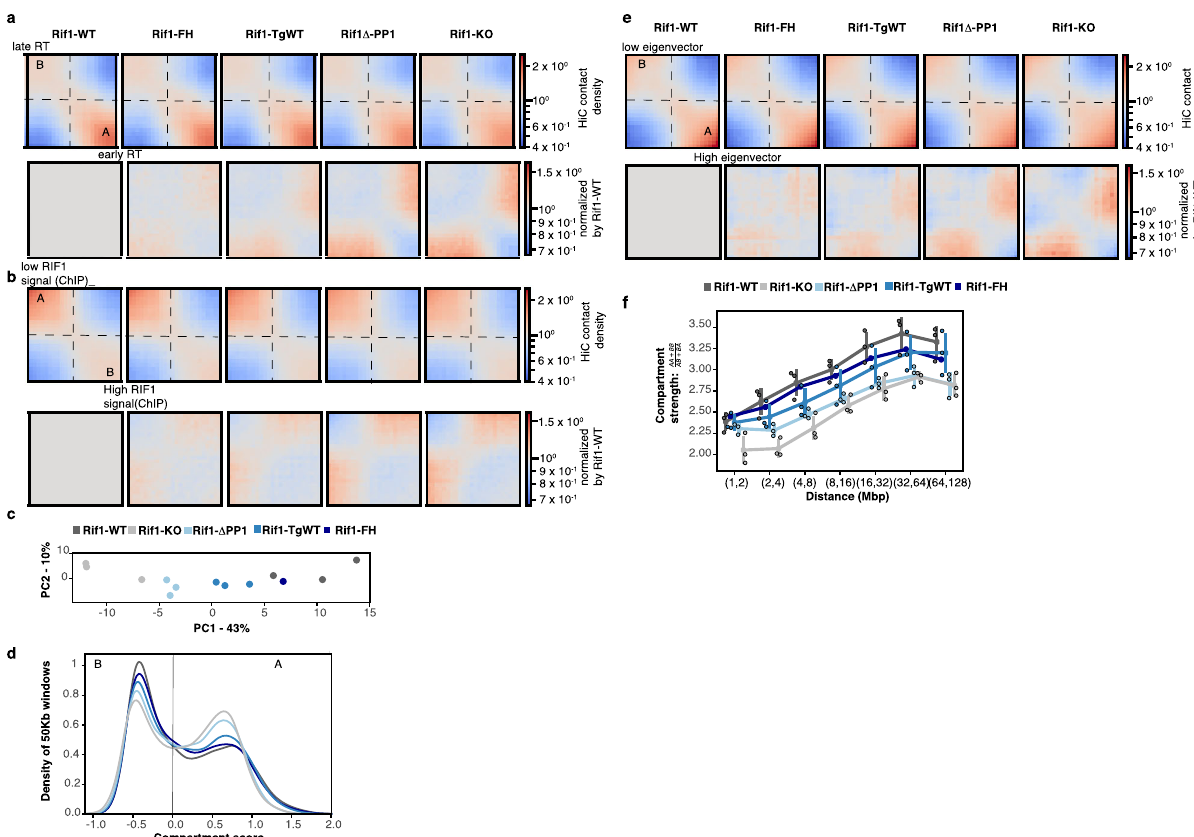
Fig. 4 Segregation of A and B nuclear compartments is sensitive to RIF1 dosage. a Top row: Saddle plot of Hi-C data, binned at 250 kb resolution for loci ranked by their replication timing. An increase in contacts of genomic positions of opposite replication timings is progressively more evident from Rif1-WT to Rif1-KO . The triplicates for each genotype (except for Rif1-FH ) were combined. Lower row: Hi-C for each genotype, data normalised to Rif1-WT . Red indicates a gain in contacts. A and B indicates the compartments. b Top row: Saddle plot of Hi-C data, binned at 250kb resolution for loci ranked by their association with RIF1 13 . An increase in contacts between RIF1-associated and RIF1-devoided genomic positions is progressively more evident from Rif1-WT to Rif1-KO . The triplicates for each genotype (except for Rif1-FH ) were combined. Lower row: Hi-C for each genotype, data normalised to Rif1-WT . Red indicates a gain in contacts. A and B indicate the compartments. c Principle component analysis of A/B compartmentalisation for the indicated genotypes in triplicate, except for Rif1-FH . d Distribution of genomic regions of 250 kb windows between the A and B compartment. Mean of three biological replicates is shown, except for the parental line Rif1-FH . e Top row: Saddle plot of Hi-C data, binned at 250 kb resolution for loci ranked by their eigenvector values. An increase in contacts between genomic positions in different compartments is progressively more evident from Rif1-WT to Rif1-KO . The triplicates for each genotype (except for Rif1-FH ) were combined. Lower row: Hi-C for each genotype, data normalised by Rif1-WT . Red indicates a gain in contacts. A and B indicates the compartments, calculated from our data. f Compartment strength variation with distance for the indicated genotypes. Individual values for the three biological replicates are represented by the outlined circles, except for Rif1-FH . The line represents the median and the bars the standard